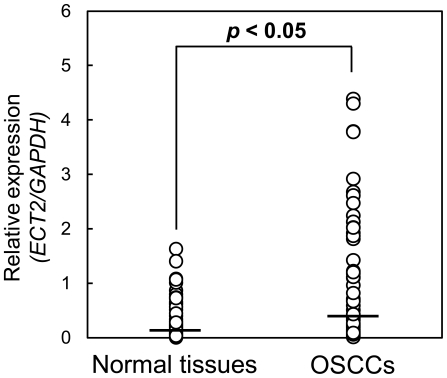
Comparison of ECT2 mRNA expression levels between primary OSCCs and matched normal oral tissues.To investigate the ECT2 mRNA expression levels in primary OSCCs and paired normal oral tissues from 96 patients, we performed qRT-PCR analysis. The relative mRNA expression levels in primary OSCCs and the matched oral tissues (n = 96) range from 0.005 to 4.39 (median, 0.289) and 0.003 to 1.632 (median, 0.081), respectively. ECT2 mRNA expression was up-regulated in 75 (78%) of 96 primary OSCCs compared with the matched normal oral tissues. Significantly higher ECT2 mRNA expression was observed in primary OSCCs than matched normal oral tissues (P<0.05; Mann-Whitney U test).